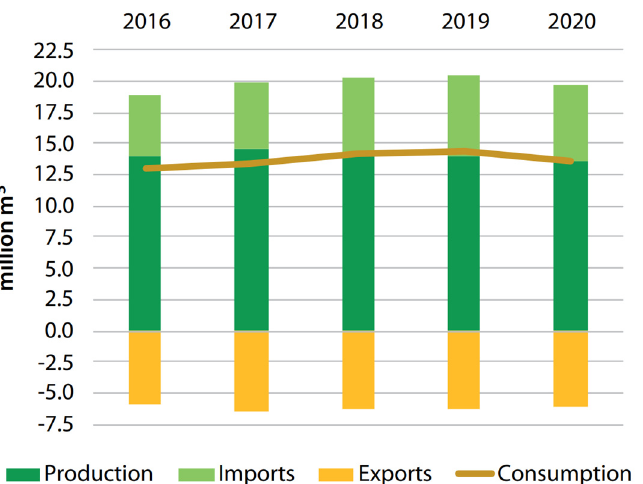
Figure 1. Sawn hardwood production, trade and consumption in Europe (exports are shown as negative numbers) [5].